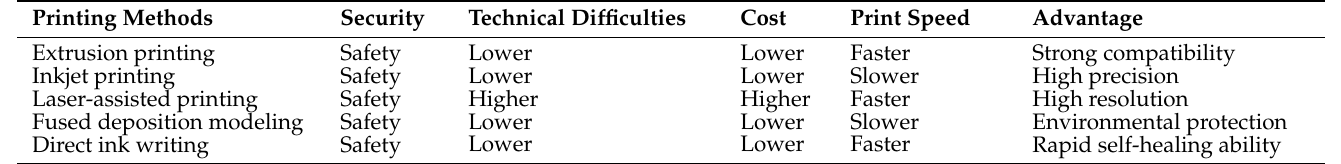
Table 1. Common methods of 3D printing and their